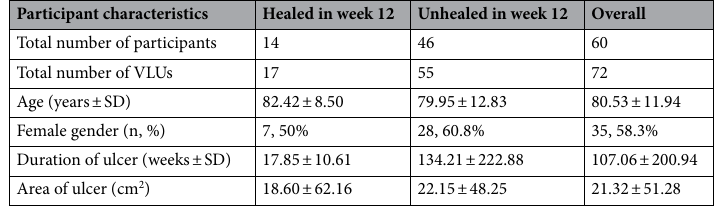
Table 1. Characteristic of participants.